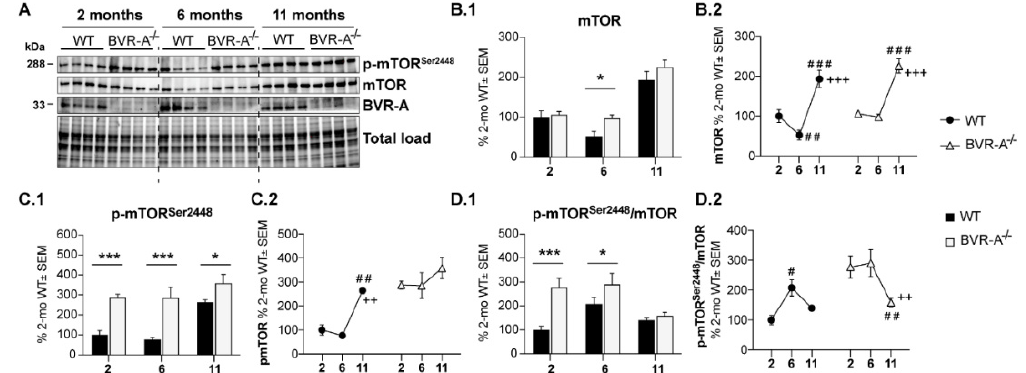
Figure 2. mTOR hyper-activation occurs in the cerebral cortex of BVR-A − / − mice. Representative western blot images ( A ) and densitometric evaluation of mTOR ( B.1 , B.2 ), p-mTOR Ser2448 ( C.1 , C.2 ) and p-mTOR Ser2448 / mTOR ratio ( D.1 , D.2 ) in the cerebral cortex of WT and BVR-A − / − mice at 2 ( n = 4), 6 ( n = 4) and 11 ( n = 4) months of age. Protein levels were normalized per total protein load. Data are expressed as percentage of WT mice at 2 months set as 100%. Columns were used to show differences among the groups (WT vs. BVR-A − / − ) while dots to show age-associated changes within each group. Data are expressed as Mean ± SEM. For columns: * p < 0.05, *** p < 0.001 vs. WT (2-way ANOVA with Fisher’s LSD test). For dots: # p < 0.05, ## p < 0.01, ### p < 0.001 vs. 2 months; ++ p < 0.01, +++ p < 0.001 vs. 6 months (2-way ANOVA with Fisher’s LSD test).